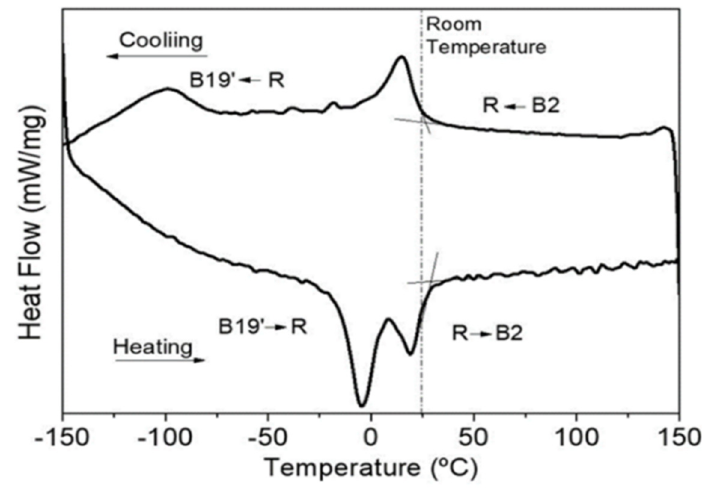
Figure 1. DSC results for NiTi wire as-received condition.